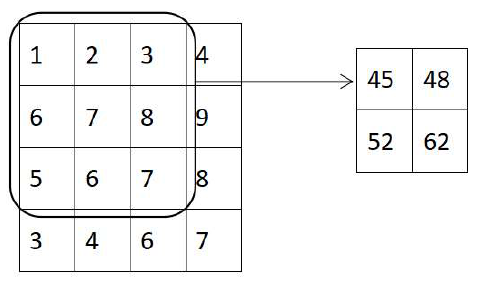
Figure 4. Maximum pool process of the CNN model.